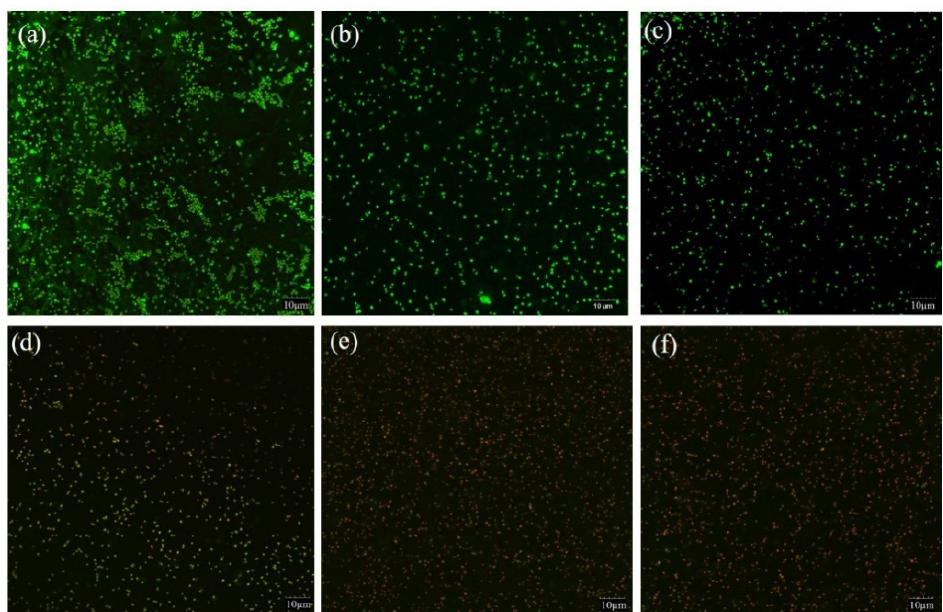
Figure 4. CLSM images of S. saprophyticus biofilm. ( a ) BK: blank control; ( b ) 100 µM CUR treat- ment only; ( c ) 17.28 J/cm 2 irradiation treatment only; ( d ) PDI treatment with 100 µM CUR and 4.32 J/cm 2 irradiation; ( e ) PDI treatment with 100 µM CUR and 8.64 J/cm 2 irradiation; ( f ) PDI treatment with 100 µM CUR and 17.28 J/cm 2 irradiation .